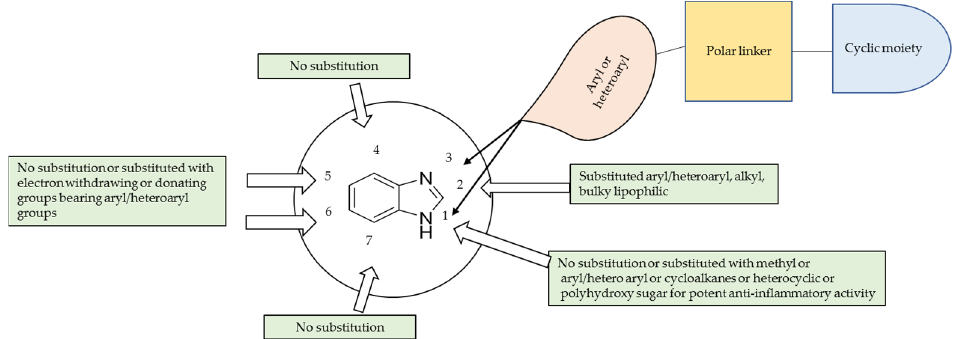
Figure 51. Summary of substituents at benzimidazole nucleus favourable for potent anti-inflammatory activity .